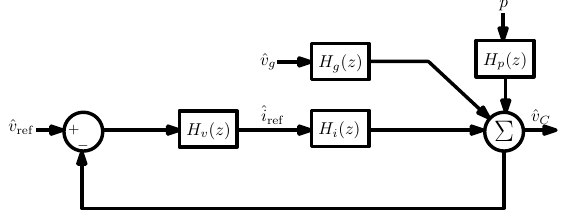
Figure 10. Block diagram of the z